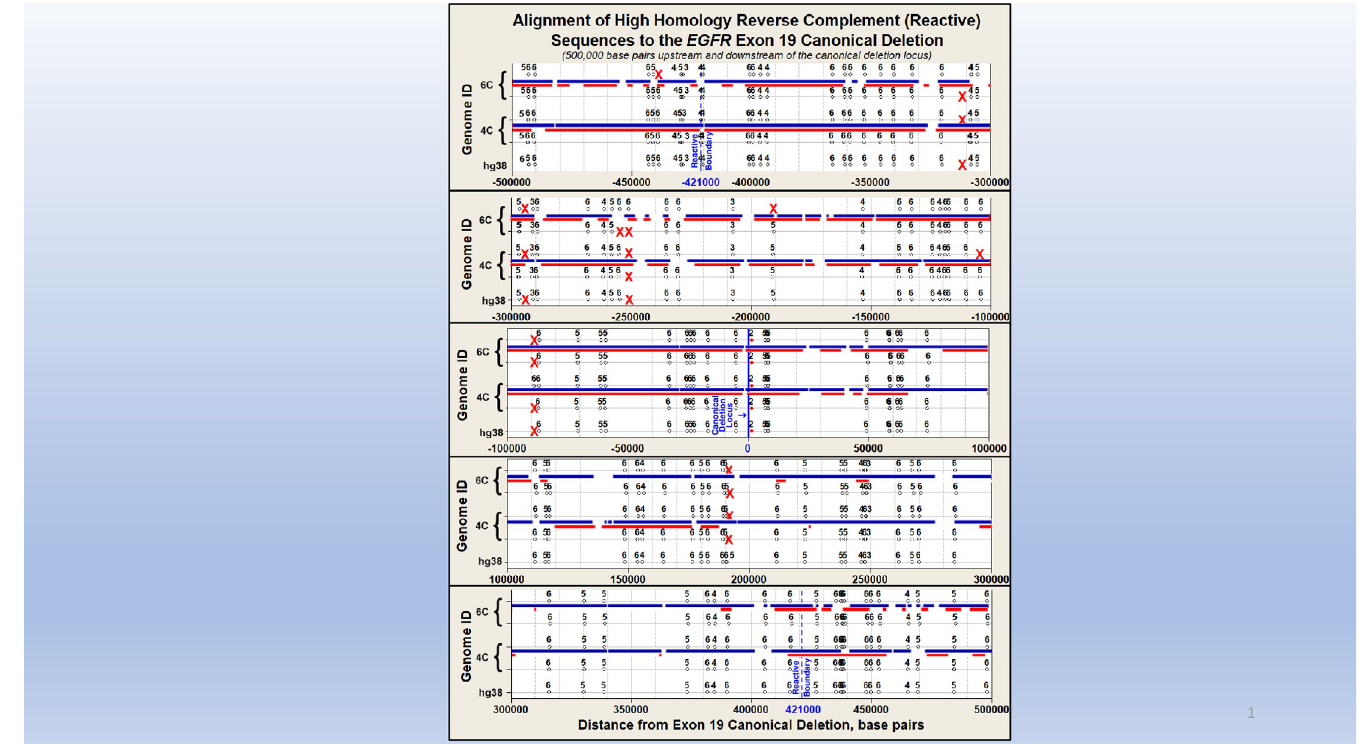
Fig 5. Reverse complement loci within ± 500,000 bp landscapes across five partially phased regions surrounding the EGFR exon 19 canonical deletion. This mega- base sized landscape spans from ± 500,000 bp of the EGFR exon 19 canonical deletion and is represented across five panes, each showing 200,000 bp. Although each of the five genome sequences in Fig 5 are identified on the Y-axis, the phase designations for each proband sequenced in this study are arbitrary as several low coverage phase discontinuities (see discussion) exist along each of these four landscapes. Horizontal red lines in each pane identify phased regions within each landscape. Horizontal blue lines identify regions where the depth of sequencing is 10-fold or greater. The absence of heterozygosity across some phase blocks prevented complete phasing of the landscapes. These regions of low heterozygosity (non-phased) are represented by blue lines only, without red lines. Note that the locus of the canonical deletion is located in the center-most pane at the X-axis value of “0” (blue line). Also note the very close proximity of the highest homology reverse complement to the canonical deletion locus which is designated as red circles. This reverse complement is separated by only 1,366 bp from the canonical deletion sequence. This is the closest locus among all 94 sets of reverse complements to the EGFR exon 19 canonical deletion sequence and are within the ± 421,000 bp region of reactivity flanking the canonical deletion. This region of reactivity is set by the statistical confidence of departure of the I:D ratio of Alu elements departure from unity (p < 0.05) (41). These statistical confidence limits are shown as blue dashed lines at ± 421,000 bp from the canonical deletion locus. Except for the solid red circles denoting the high homology reverse complement, all remaining reverse complements are identified as black circles with the number of mismatches from the 15 bp canonical deletion shown above each circle. Each red X denotes a missing reverse complement that is present in one or more of the other landscapes. A total of 22 reverse complements are absent across one or more of these five haplotypes shown in this Fig 5. It is important to note that although phase identity is not possible within each proband, the presence of homologous phase blocks across the probands permitted identification of reverse complement variation across these five ± 500,000 bp landscapes.